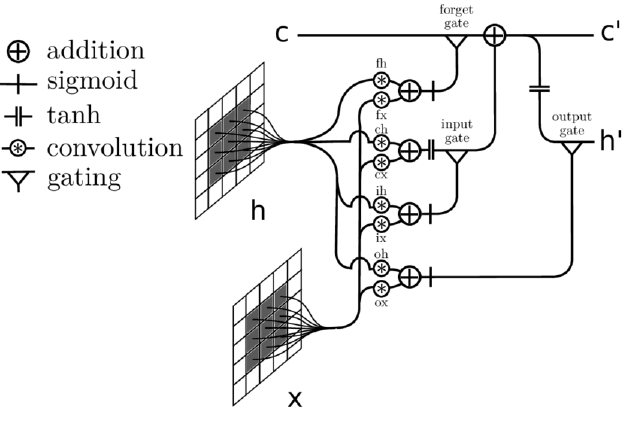
Figure 3. ConvLSTM structure